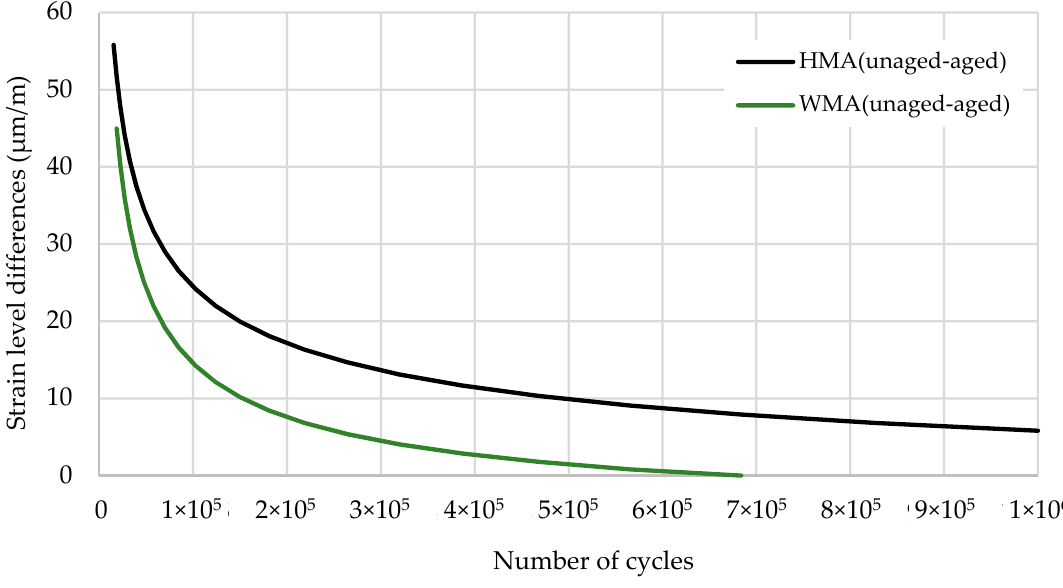
Figure 12. HMA and WMA sensitivity to aged condition.